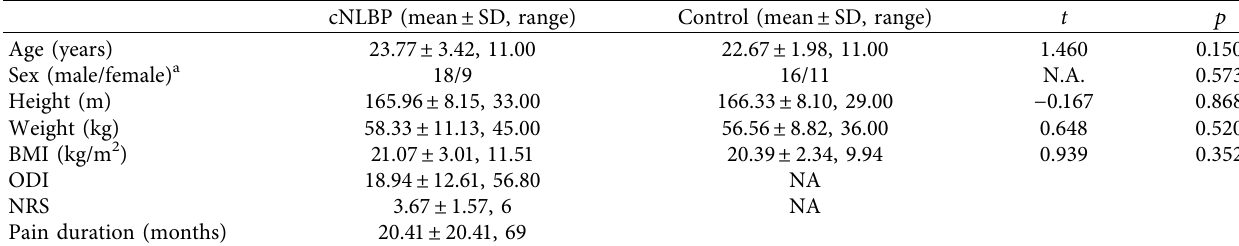
Table 1: The demographic characteristics of the sample populations.